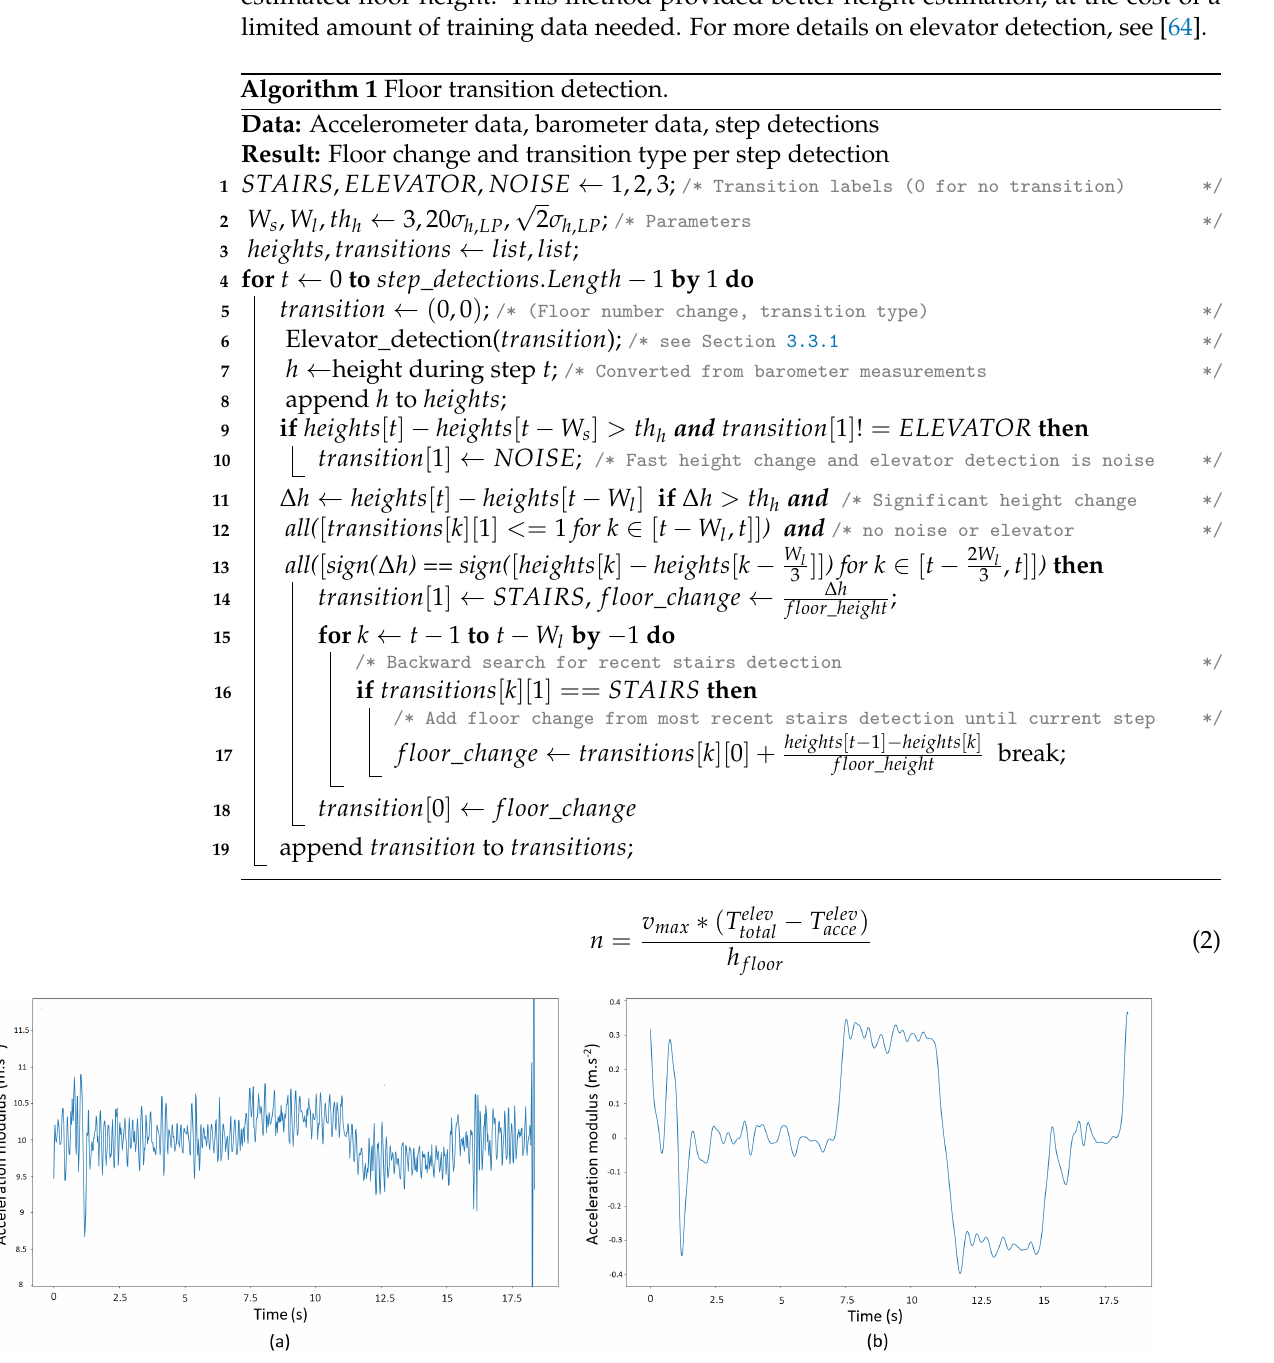
Figure 3. Acceleration modulus while the pedestrian is taking an elevator. Before ( a ) and after ( b ) filtering with the Gaussian low-pass filter and removal of the gravity